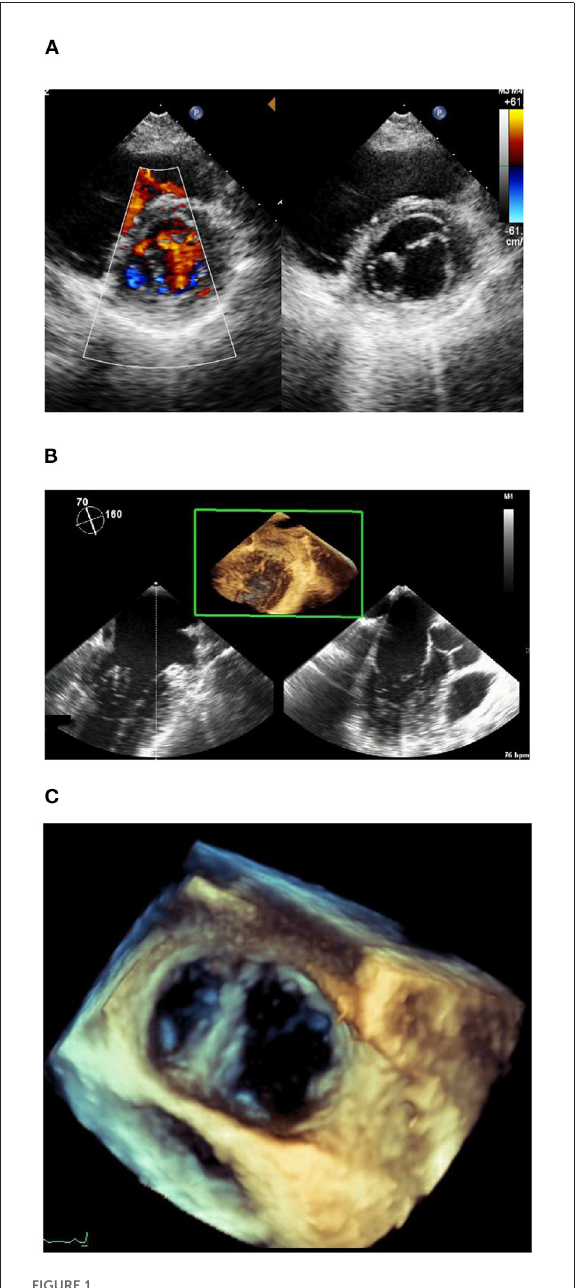
FIGURE1 (A) Short axis of echocardiogram image. (B) Transesophageal echocardiogram. (C) Transesophageal